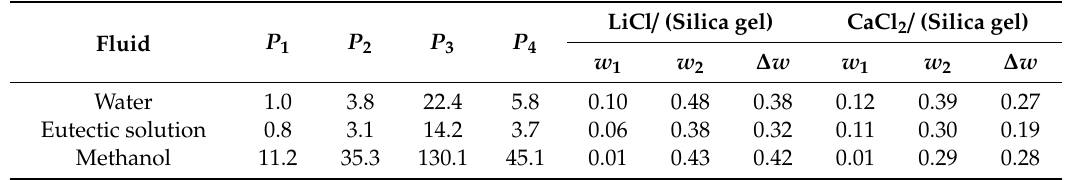
Table 5. Comparison of the boundary pressures P (mbar), uptakes w and ∆ w (g / g) for the analyzed HeCol cycle with various fluids in the evaporator /